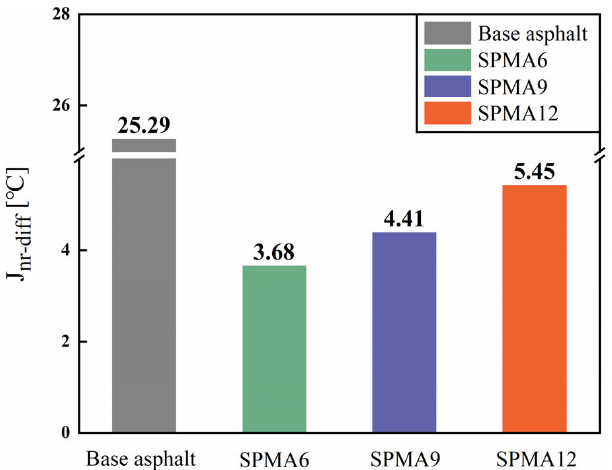
Figure 14. Calculating values of J nr ‐ diff .